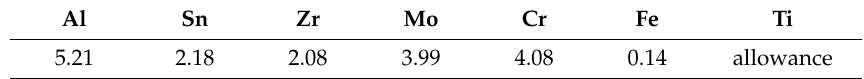
Figure 1. Microstructure of the TC17 base metal. Table 1. Chemical composition of TC17 titanium alloy (%).